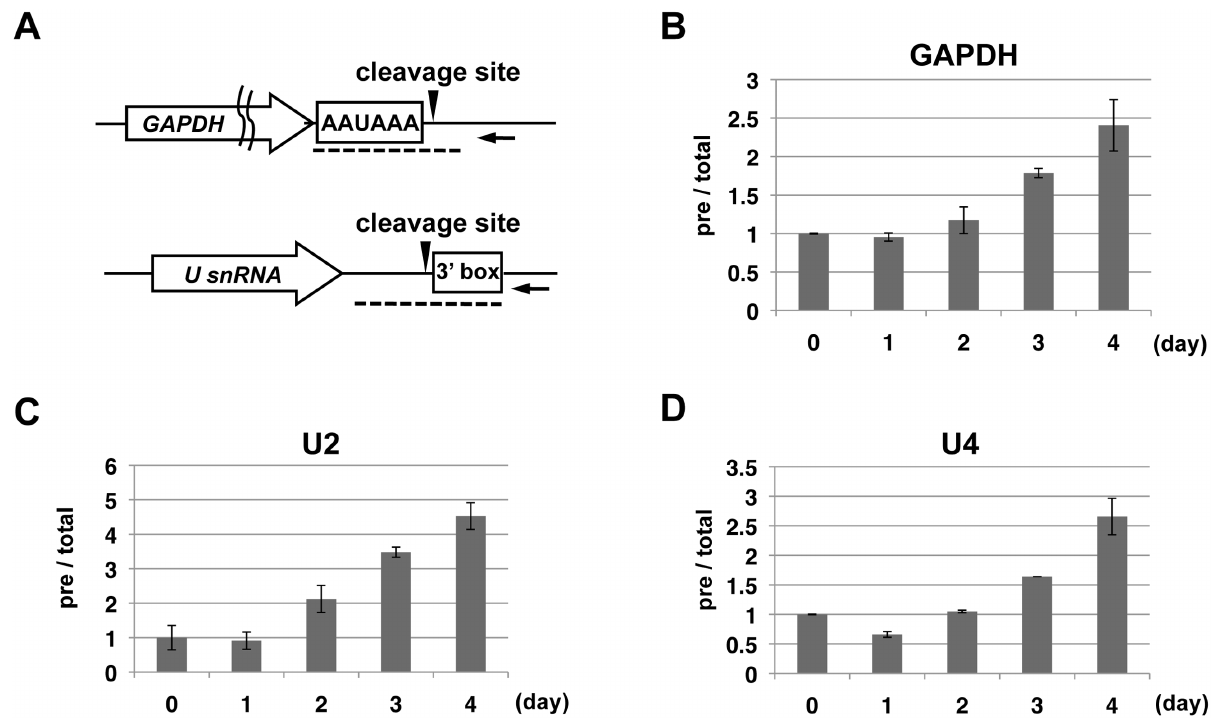
Figure 4. Ssu72 is required for 3 9 -end formation of GAPDH mRNA and U2 and U4 snRNAs. (A) Diagrams of the GAPDH (upper) and U snRNA genes (lower), shown as open arrows, with the cleavage sites depicted as arrowheads and RNA processing elements indicated in the open boxes. The black arrows represent the gene-specific primers used for reverse transcription of precursor transcripts. Dotted lines indicate the RT-qPCR amplicons used to quantitate the precursor transcripts. (B–D) RT-qPCR analysis of the relative expression levels of precursor (pre) and total transcripts of GAPDH (B), U2 snRNA (C) or U4 snRNA (D) in DT40 P3 ( 2 / 2 ) cells treated with Dox for the indicated number of days. Relative expression levels were normalized the corresponding levels on day 0. Error bars represent standard deviations of at least two independent experiments.